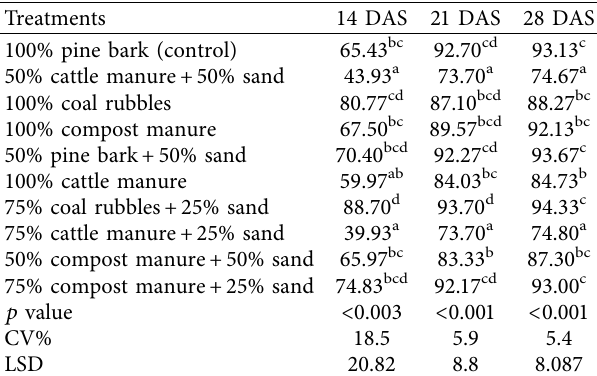
Table 1: The effect of soilless growing media on seed emergence percentage (%) of tobacco.